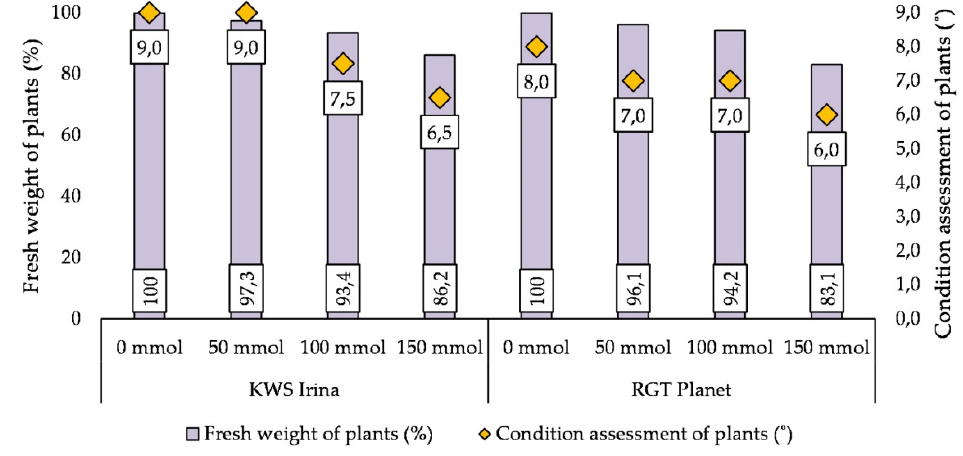
Figure 4. The effect of salt stress on the condition of the plants and the content of the fresh mass of barley plants in the KWS Irina and RGT Planet cultivars.